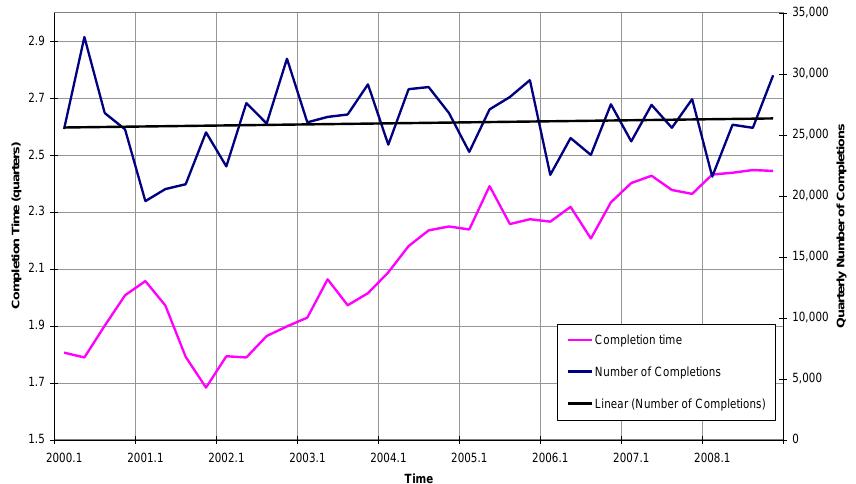
Figure 4: Average house completion time trend and quarterly number of completions in